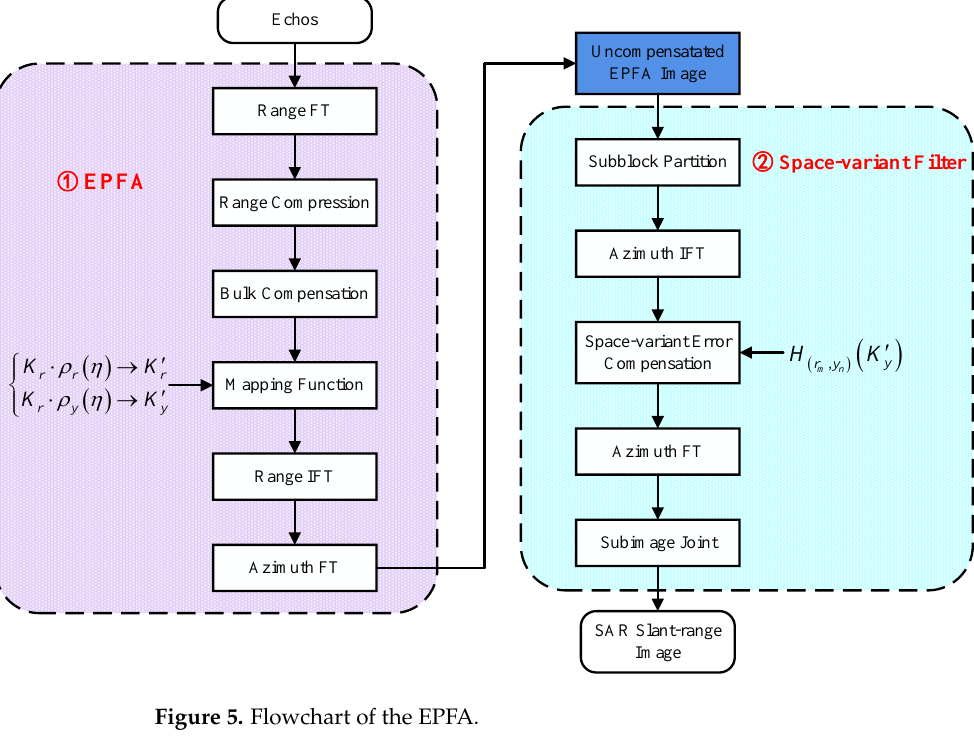
Figure 5. Flowchart of the EPFA.